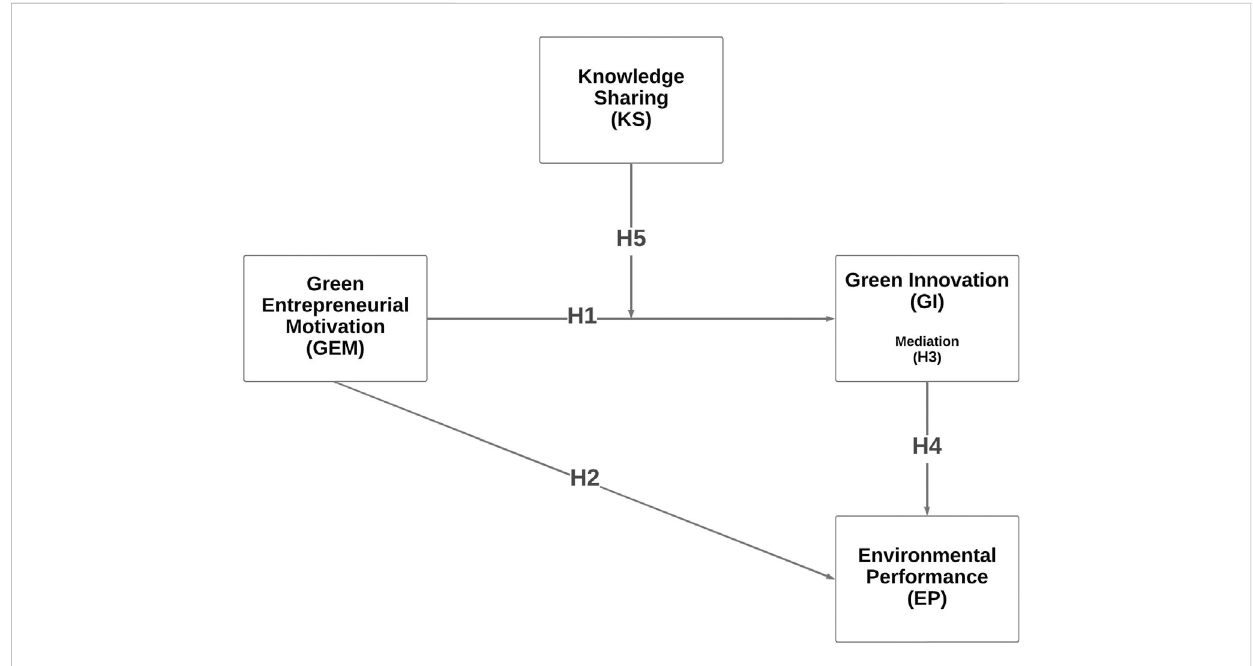
FIGURE 1 Developed study model. Source: